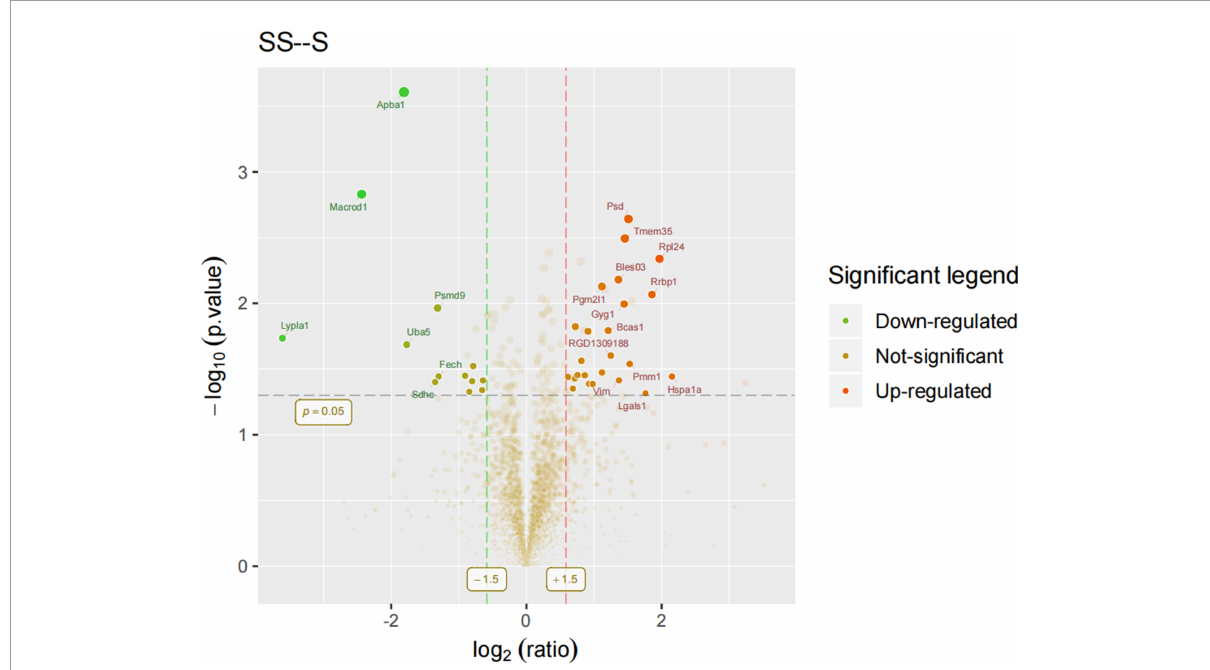
FIGURE6 Volcano diagram: Rats 9–14 in the sham group and 9–13 in the SDR group. Differentially expressed proteins were displayed in the volcano diagram. Y -axis: -log10 ( p -value); X -axis: log2 (ratio). The dots that lie beyond the two vertical boundaries and above the horizontal boundaries represent proteins that differ significantly. Clear spots in salient regions mean that these proteins do not meet the other conditions.